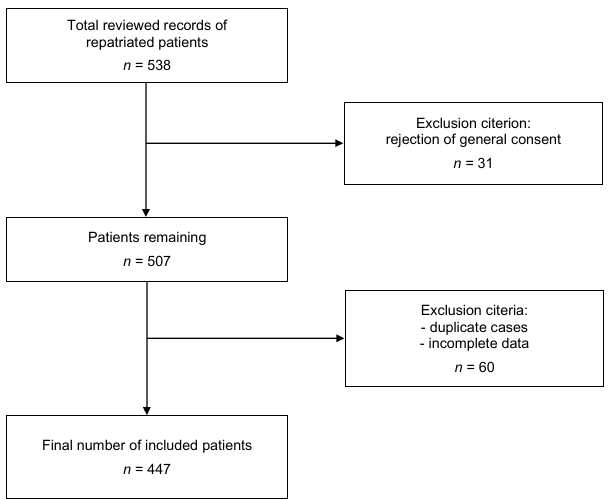
Figure 1. Flow chart of medical record selection .